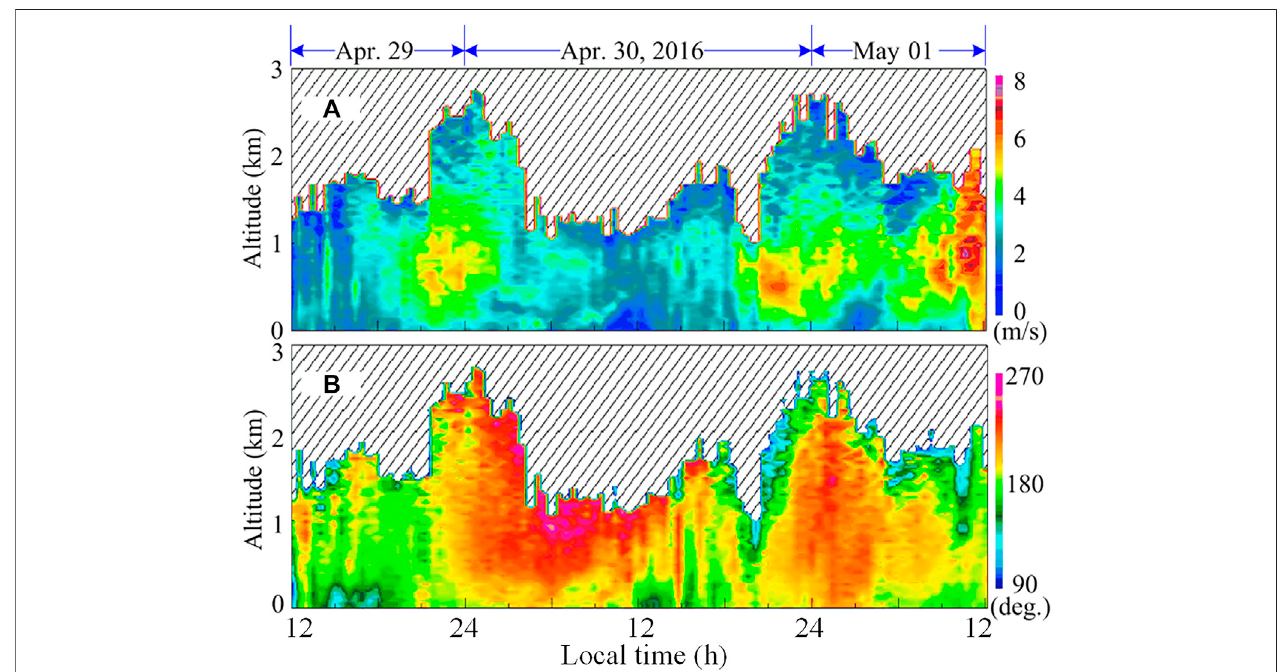
FIGURE 3 | Forty-eight-hour observation of atmospheric wind and visibility. (A) Wind speed and (B) direction.